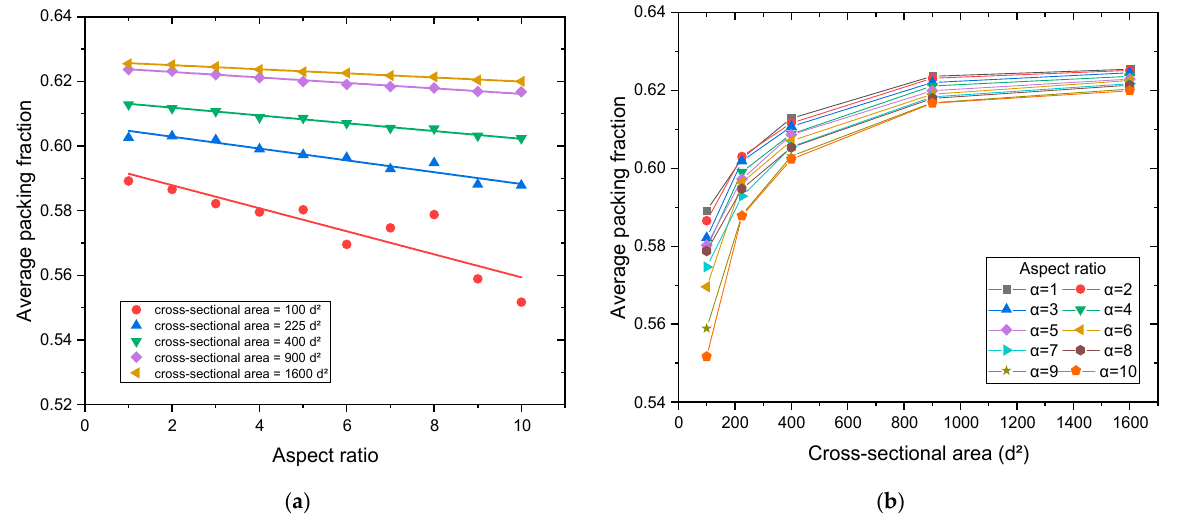
Figure 5. Average packing fraction of the rectangular packed pebble beds ( a ) as a function of the aspect ratios and ( b ) as a function of the cross-sectional areas of the pebble beds.